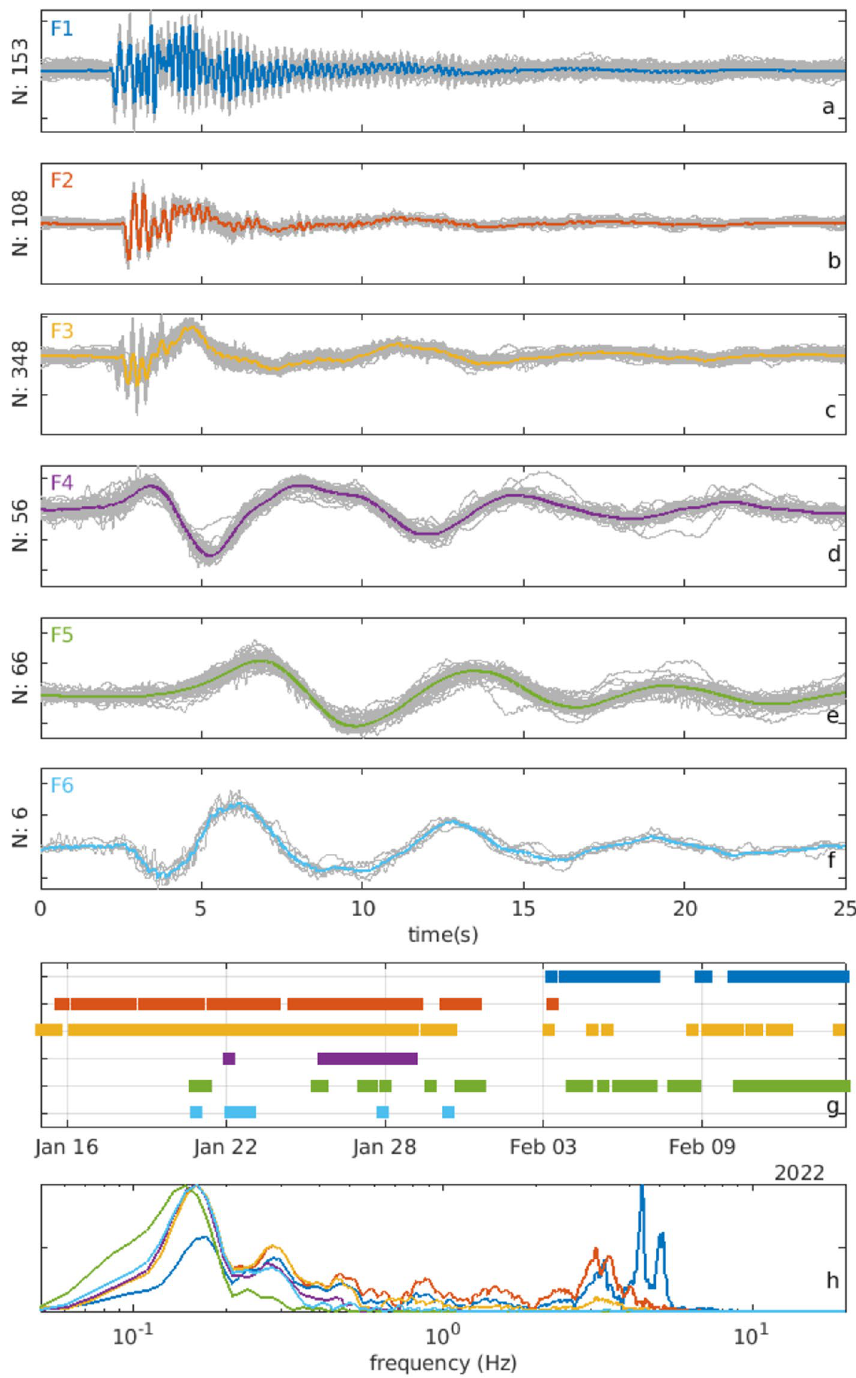
Figure 8. Stacked waveforms (thick coloured lines) of individual normalized events (thin gray lines) for the six identified families recorded at IVCR station ( a – f ). Each signal is normalized by centering the data to zero mean and scaling them to unity standard deviation. Temporal distribution of the occurrence of the IVCR classified events ( g ). Normalized spectra of the stacked waveforms ( h